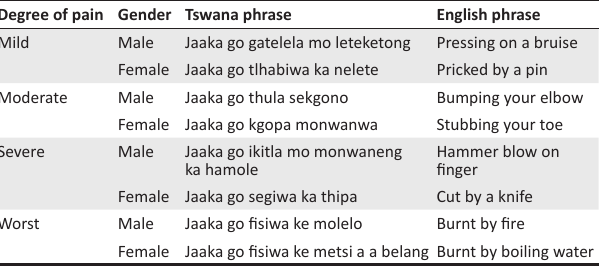
TABLE 1-A1: Tswana version of the Tswana Verbal Pain Descriptor Scale showing male and female descriptors.